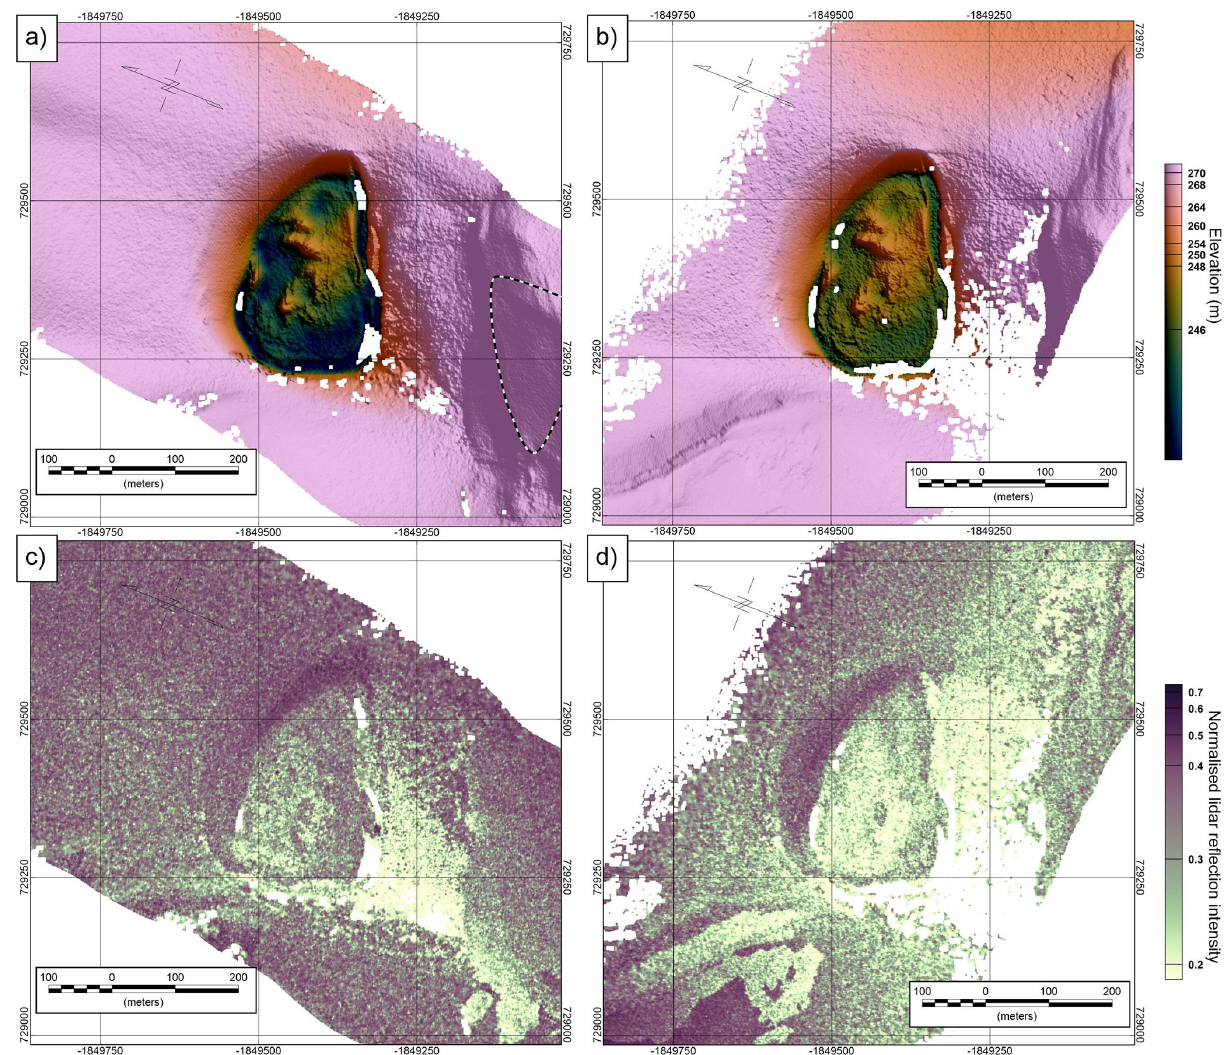
Figure 3. Lidar imaging of PICS. (a) Lidar elevation from flight on 22 December 2019. Dashed black and white line outlines the area of bedrock used as a reference elevation to correct elevation of satellite strip images in Figs. 5 and 6. (b) Lidar surface elevation from flight on 30 December 2019. (c) Lidar reflection intensity from 22 December 2019 flight. (d) Lidar reflection intensity from 30 December 2019 flight. Note the catchment depression extending southward from the PICS imaged on 22 December (bottom right of images) had a low/absent reflection intensity on 30 December due to the presence of numerous supraglacial meltwater